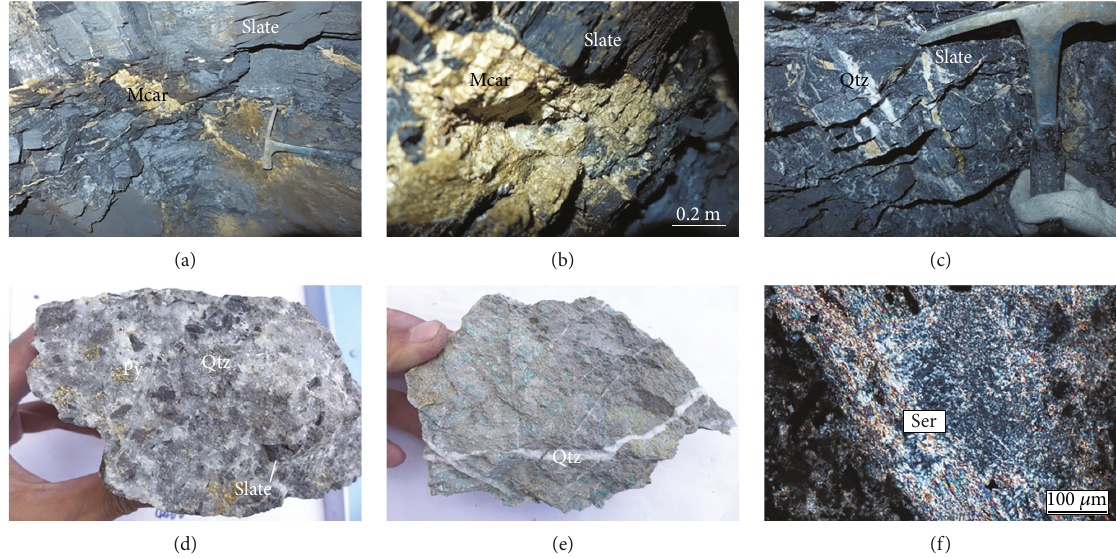
Figure 3: Hydrothermal alteration within the Keyue ore fi eld. (a) Mn – Fe carbonate vein cut slate; (b) Mn – Fe carbonate in slate; (c) quartz veins cut slate; (d) the quartz that contains slate breccias and pyrite; (e) quartz vein cut altered rock; (f) sericitization. Mcar=Mn – Fe carbonate, Qtz=Quartz, Py =pyrite,